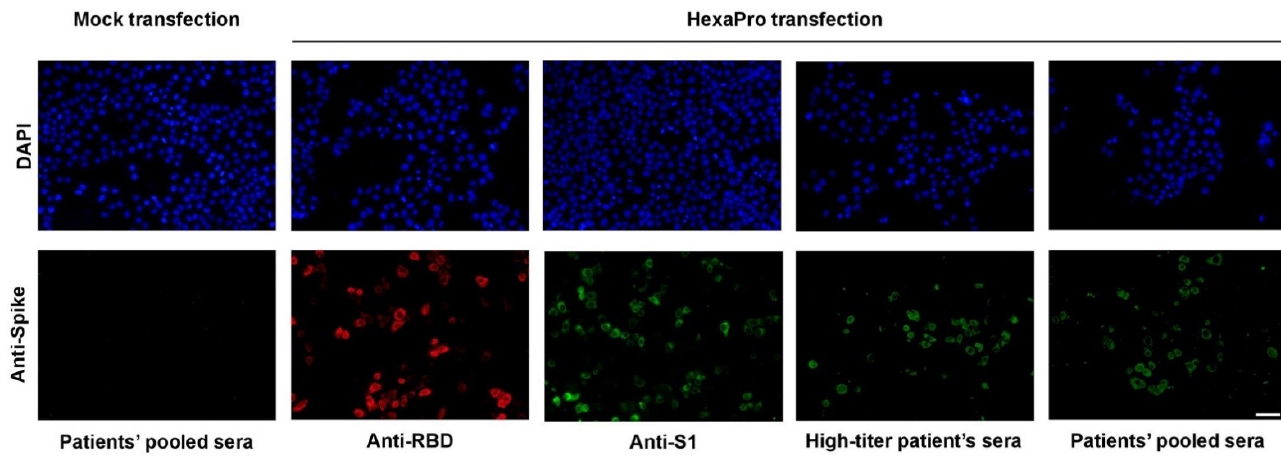
Figure 2. Immunofluorescence staining of the HexaPro spike expressed in HeLa cells using antibodies against spike RBD and S1 subunits, and convalescent sera derived from a patient with high-titer neutralization activity and from pooled sera. Scale bar: 50 µm.